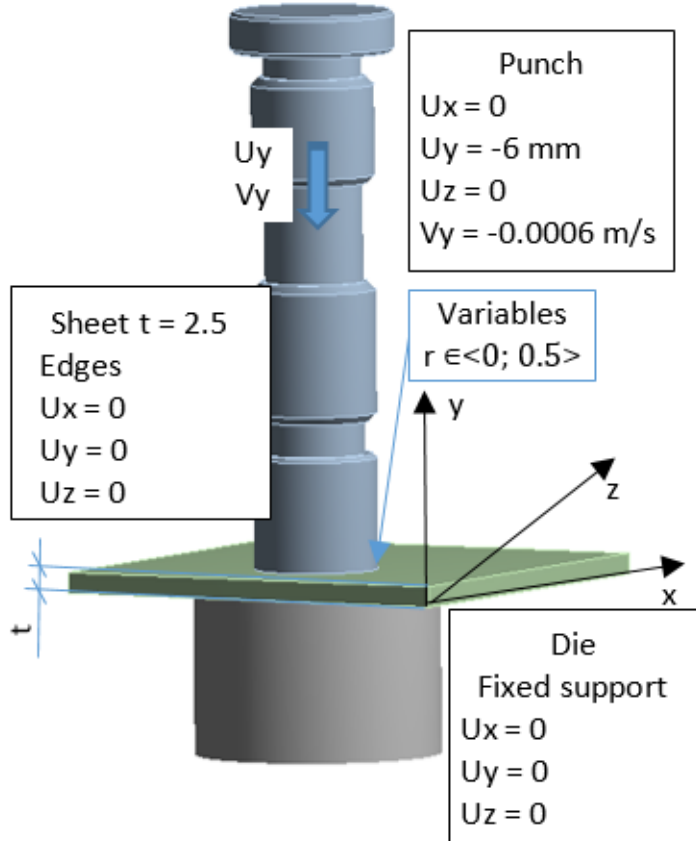
Figure 11. The initial and boundary conditions in modeling of nibbling process.